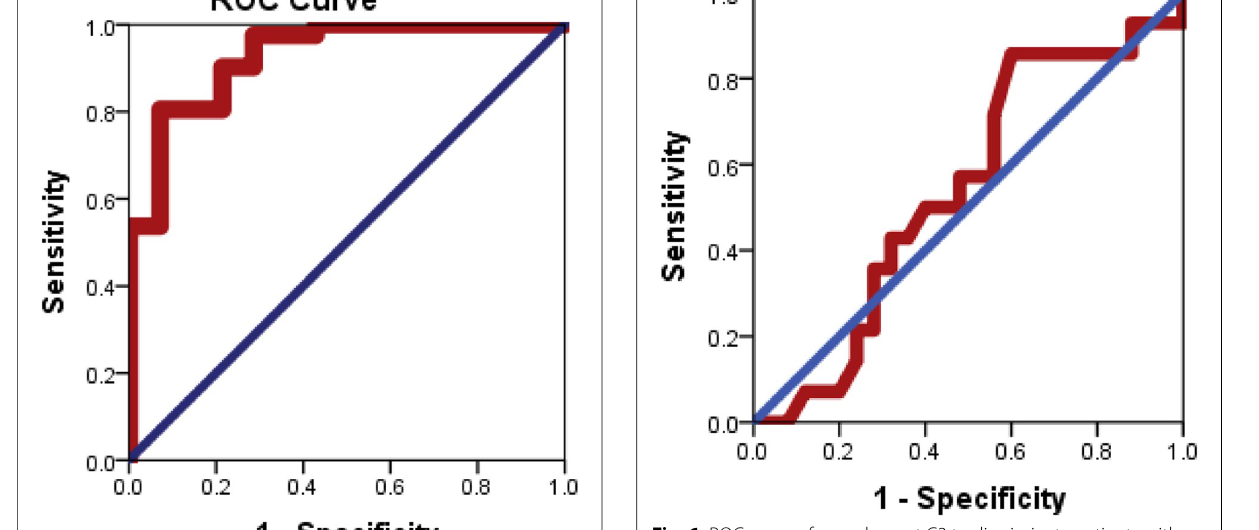
Fig. 6 ROC curve of complement C3 to discriminate patients with Fibrosis-4 score of less than 1.30 from patients with a Fibrosis-4 score of more than